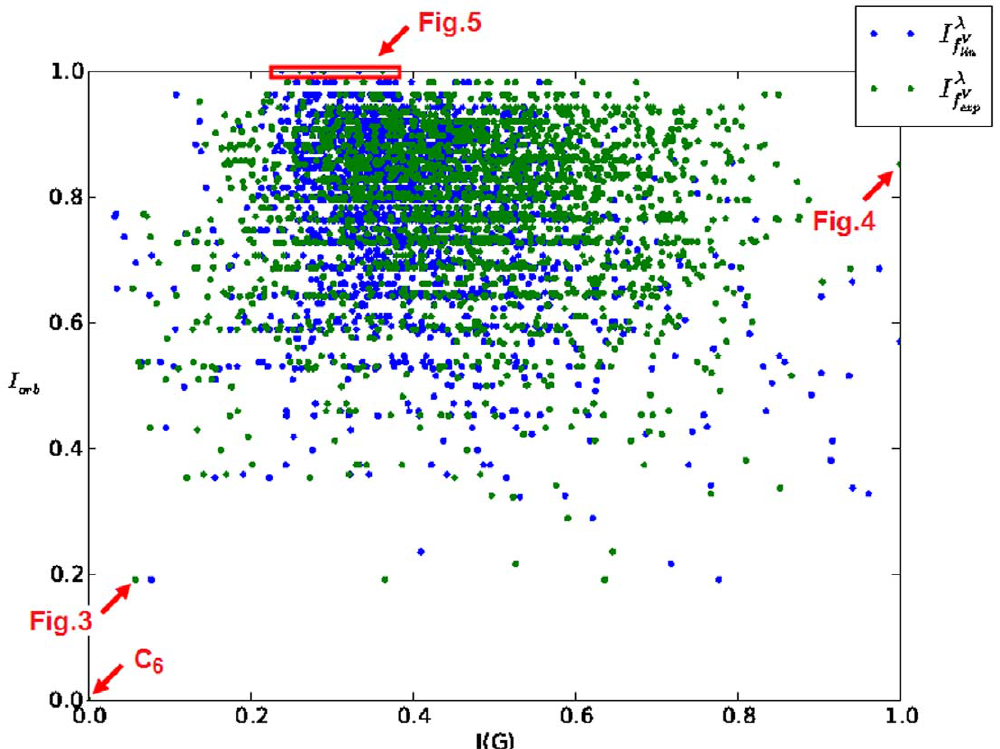
Figure 1. I orb versus I l